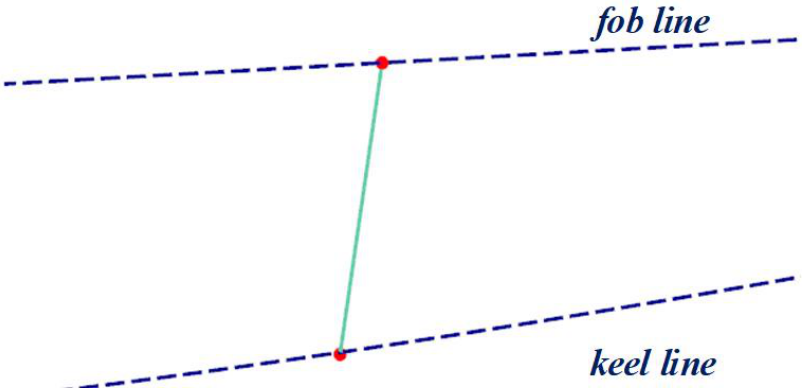
Figure 9. Definition of stations: straight curves.